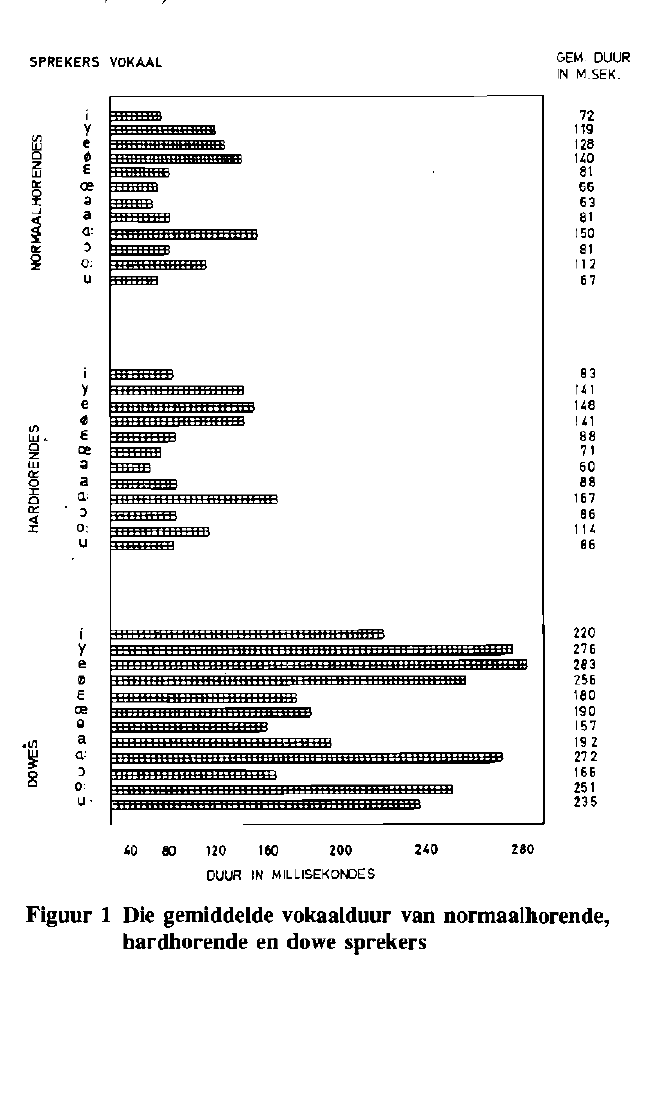
Figuur 1 Die gemiddelde vokaalduur van normaalhorende, hardhorende en dowe